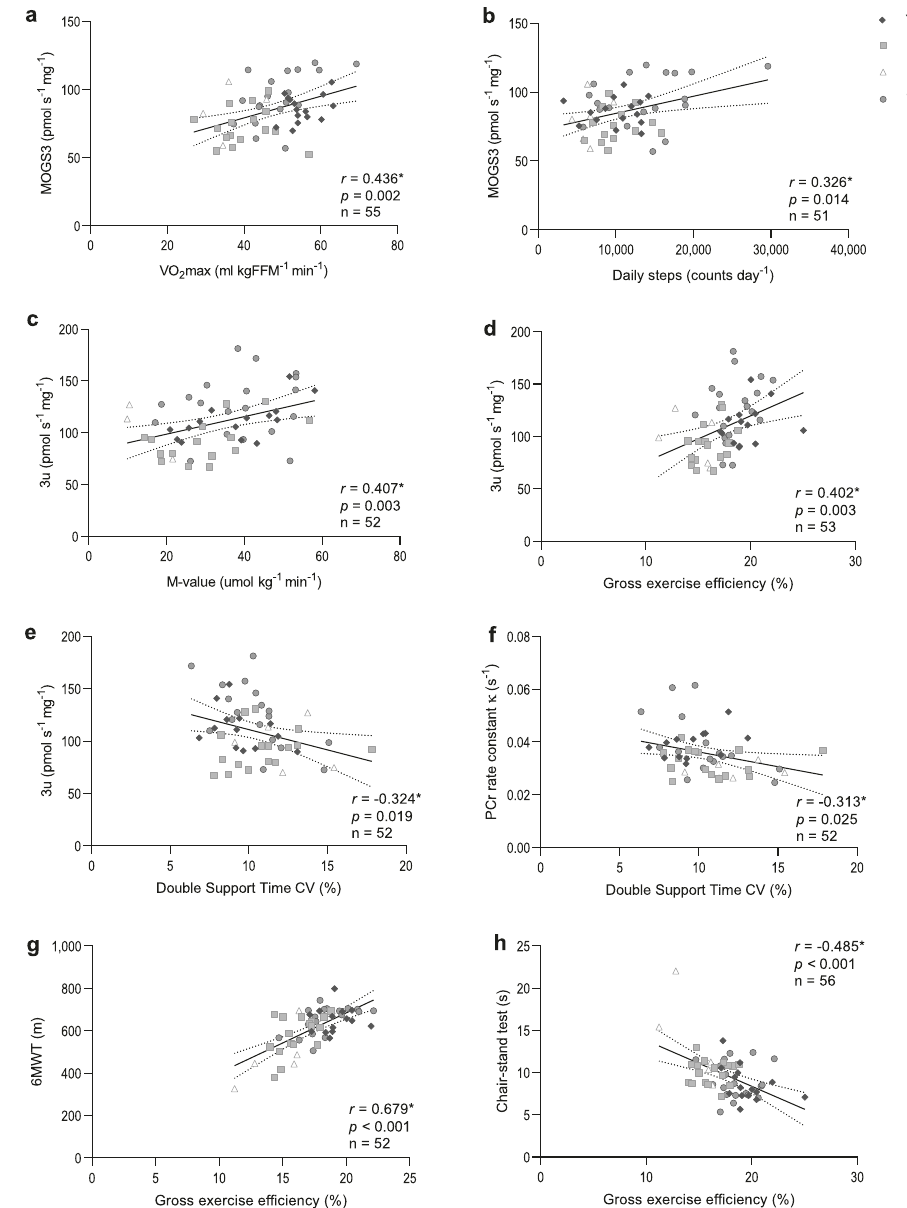
Fig. 7 Bivariate correlations between mitochondrial function and physical muscle function. a Correlation between maximal exercise capacity and maximal coupled mitochondrial respiration. b Correlation between physical activity and maximal coupled mitochondrial respiration. c Correlation between whole-body insulin sensitivity and maximal uncoupled mitochondrial respiration. d Correlation between gross exercise ef fi ciency and maximal uncoupled mitochondrial respiration. e Correlation between step variability and maximal uncoupled mitochondrial respiration f Correlation between step variability and in vivo PCr recovery rate constant. g Correlation between walking performance and gross exercise ef fi ciency. h Correlation between SPPB chair-stand test and gross exercise ef fi ciency. Dark gray diamonds indicate young normally active individuals (Y), light gray squares indicate normally active older adults (O), white triangles indicate physically impaired older adults individuals (IO), and dark gray circles indicate trained older adults (TO). Asterisk indicates the correlation is signi fi cant at the 0.05 level (2-tailed, p < 0.05); Best- fi t trend line and 95% con fi dence intervals are included. MOGS3 state 3 respiration upon malate + octanoyl-carnitine + glutamate + succinate, 3u state 3 uncoupled respiration upon FCCP, κ phosphocreatine resynthesis rate constant, 6MWT 6-min walk test, VO 2 max maximal aerobic capacity, FFM fat-free mass, Nm newton meters, M -value mean glucose infusion rate, r Pearson correlation coef fi